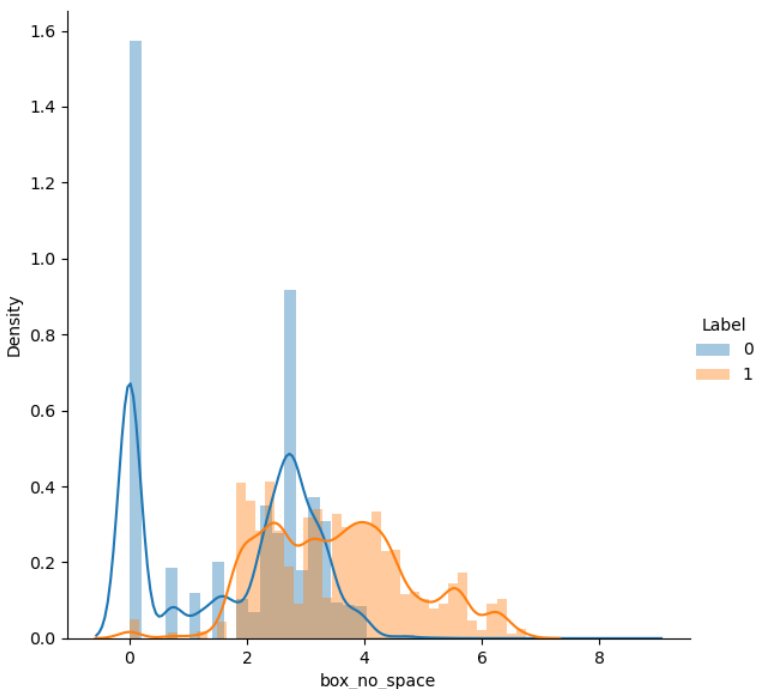
Figure 13. Distribution map of feature 8 after Box-Cox transformation. The horizontal coordinate indicates the Box-Cox transformation of the number of spaces in the queries, and the vertical coordinate indicates the corresponding probability density function. The blue line indicates benign samples and the orange line indicates malicious samples. It can be seen that there is still plenty of overlap between the two categories.